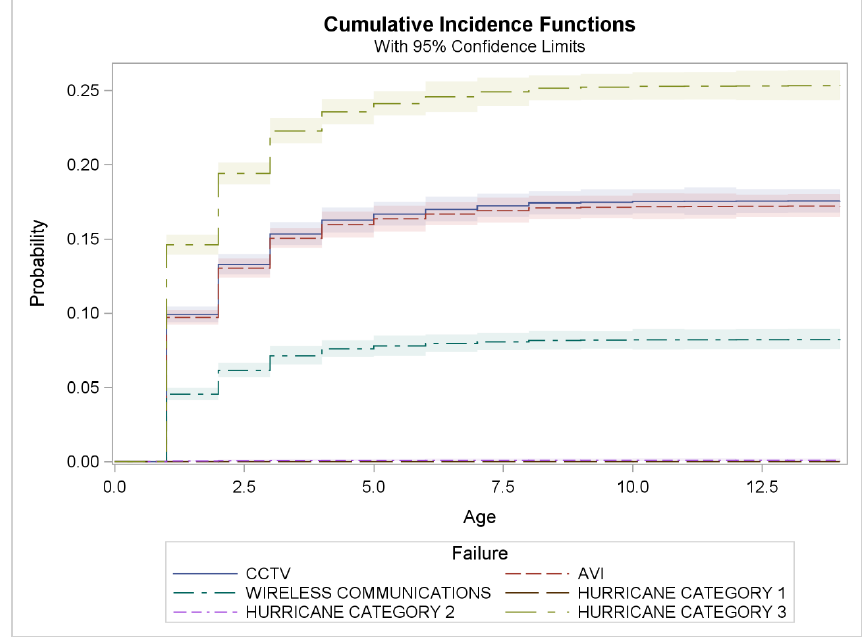
Figure 9. Cumulative incidence function estimates for vehicle-tracking and detection systems compared with hurricane failure intensities.